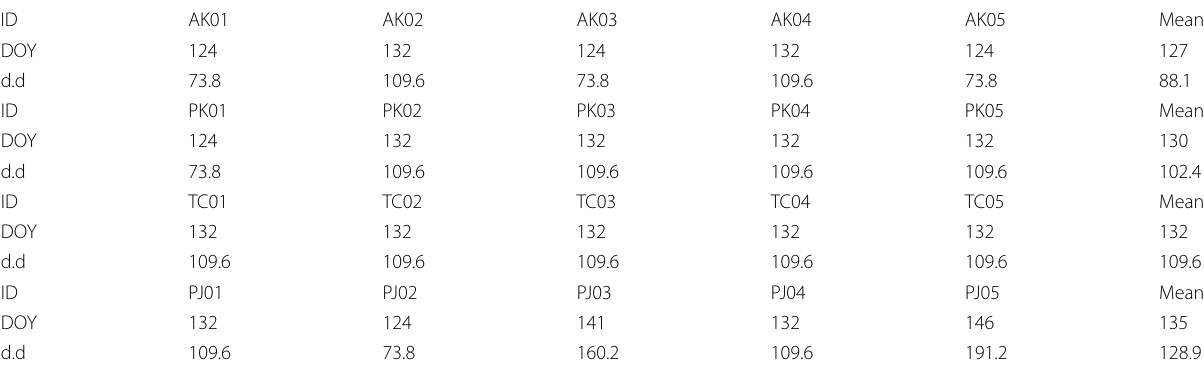
Table 2 Day of a year (DOY) for initiation of cambial activity and the corresponding degree‑days (d.d.) for Abies koreana (AK), Pinus koraiensis (PK), Taxus cuspidata (TC), and Picea jezoensis (PJ) in